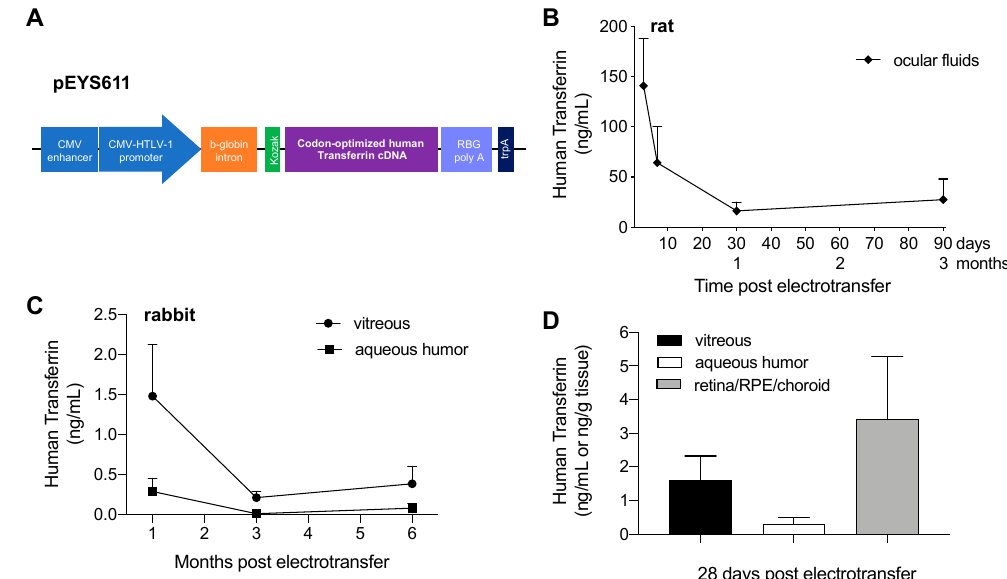
Figure 2. pEYS611-driven sustained human transferrin (TF) intraocular production in rats and rabbits. ( A ) The human TF expression cassette is composed of a human cytomegalovirus (CMV) enhancer, a chimeric CMV-HTLV (human T-cell leukemia virus)-I ubiquitous promoter, the ß-globin intron, and a Kozak sequence driving the expression of the human TF. ( B , C ) Human TF expression profiles in rat ocular fluids ( B , n = 5–7 animals per timepoint) and rabbit aqueous humor and vitreous ( C , n = 3–9 animals per timepoint) after bilateral ciliary muscle administration of pEYS611 at the doses of 30 and 45 µg/eye, respectively, demonstrated sustained expression of human TF for at least 3 and 6 months, in rat and rabbits, respectively. ( D ) Human TF distribution in rabbit eyes 28 days following pEYS611 administration demonstrated that the expressed protein reaches the back of the eye. Values are presented as mean ± sem.